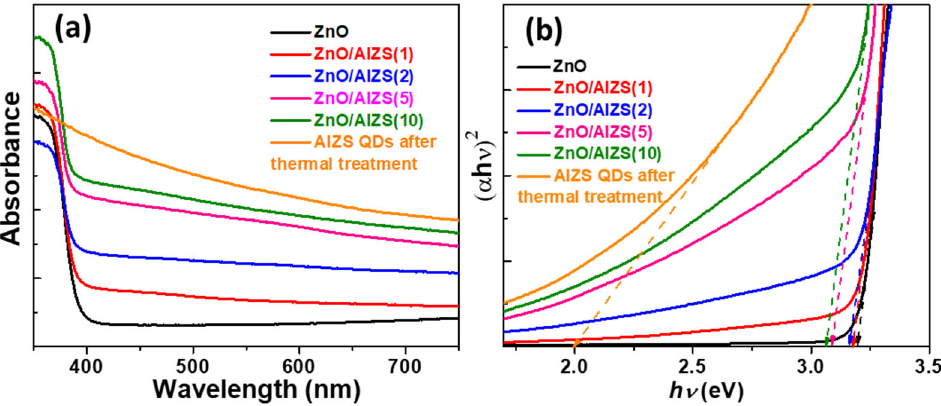
Figure 4. ( a ) UV ‐ visible DRS analyses and ( b ) the estimated bandgap energies of ZnO NRs, AIZS QDs and ZnO/AIZS